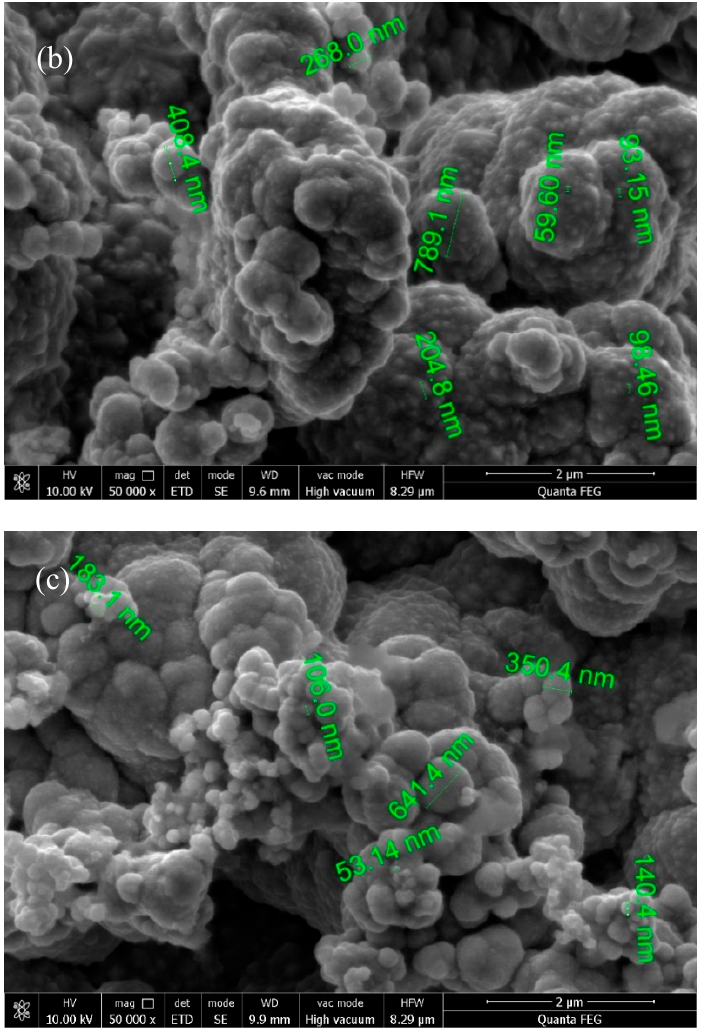
Figure 6. Morphology of composite coatings prepared by different plating methods (×50,000): ( a ) DC electroplating, ( b ) single-pulse plating, ( c ) double-pulse plating.